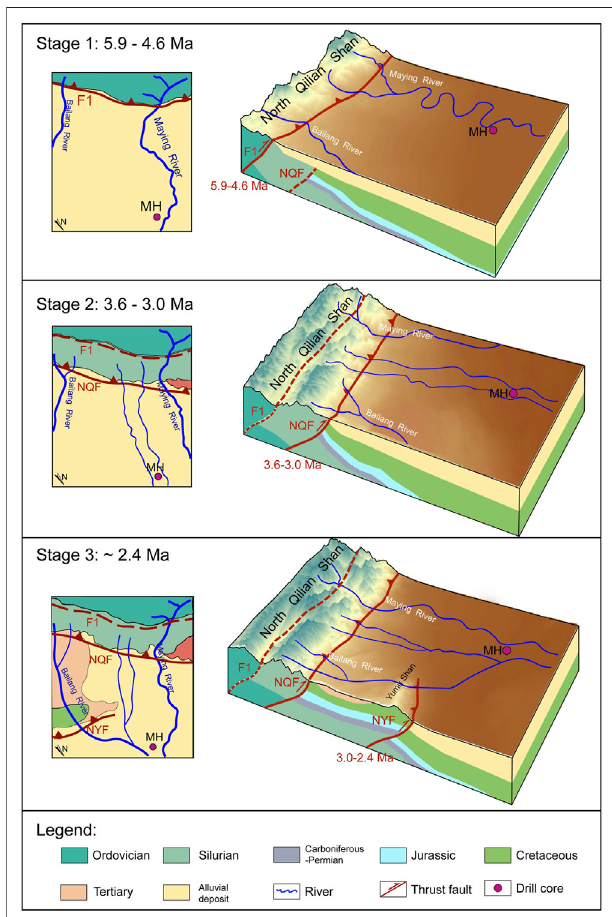
FIGURE 6 | The progressive deformational model of the North Qilian ShanduringlateCenozoic.NQF — NorthQilianShanFault;NYF — NorthYumu ShanFault.Stratigraphictexturemodi fi edfromthe1:500,000geologicmapof China(EGPGYO, 1989)and seismic sections in theJiuquan Basin (Yang et al., 2007; Zuza et al.,